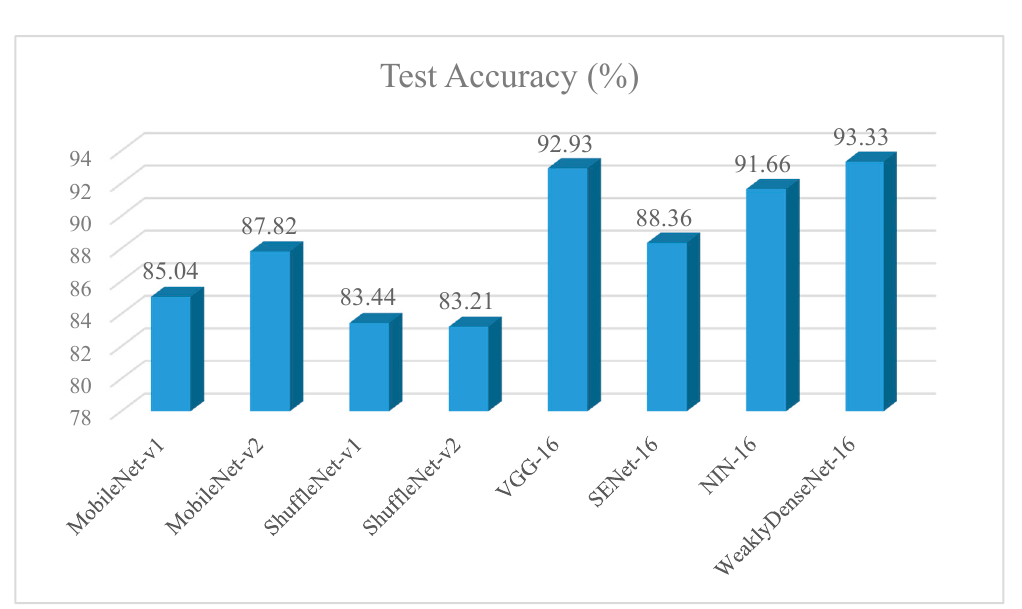
Figure 9. Comparison of the test accuracy.